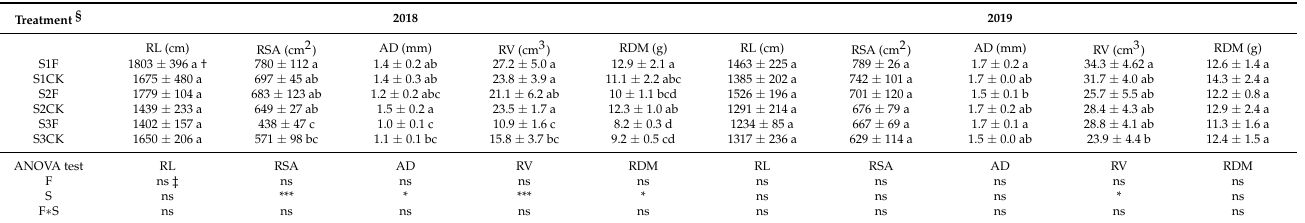
Table 2. Parameters of the roots collected in the depth of 0–120 cm after the last cut under different treatments in both 2018 and